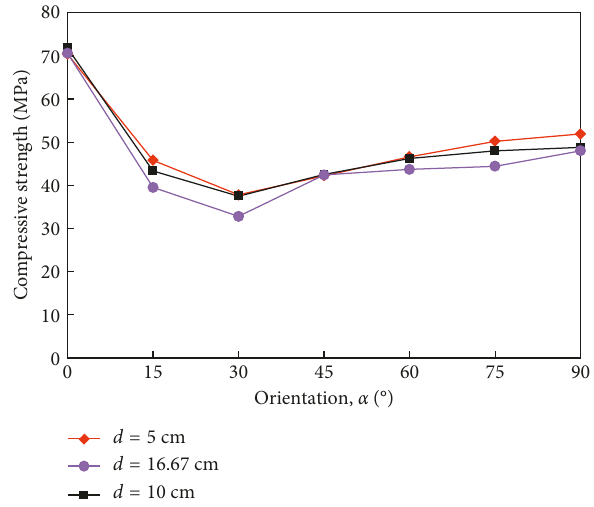
Figure 13: Uniaxial strength of numerical specimens at different orientations with different layer thickness.